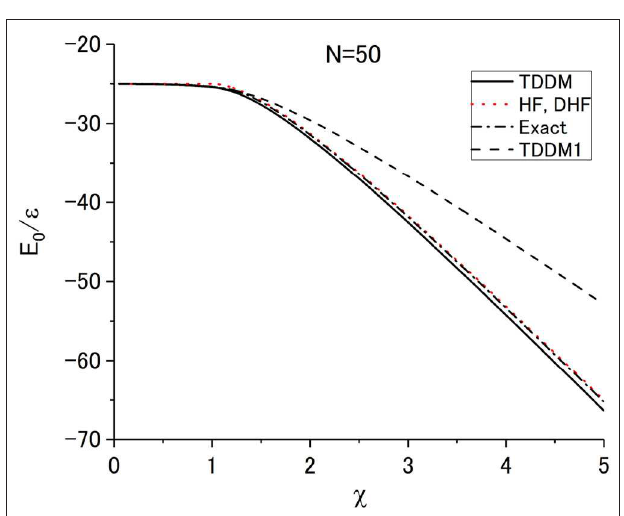
FIGURE 2 | Ground-state energy in TDDM (solid line) as a function of χ for N 50. The exact values are given with the dot-dashed line. The dashed line = depicts the results in TDDM1. The results in TDDM2 lie between the TDDM results and the exact values and are not displayed here. The results in HF and DHF( χ > 1) are shown with the dotted line but cannot be distinguished from the exact values in the scale of the figure except for the region χ from Tohyama and Schuck [45] with permission from Societ Fisica/Springer-Verlag GmbH Germany.